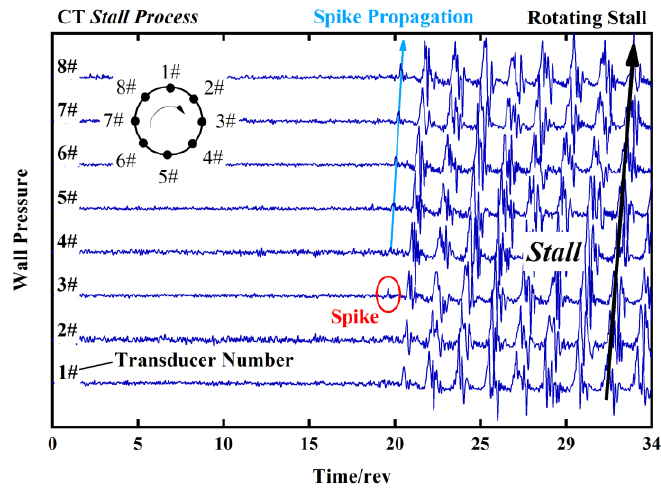
Figure 9. Eight wall pressure traces during throttling to stall the compressor in CT .